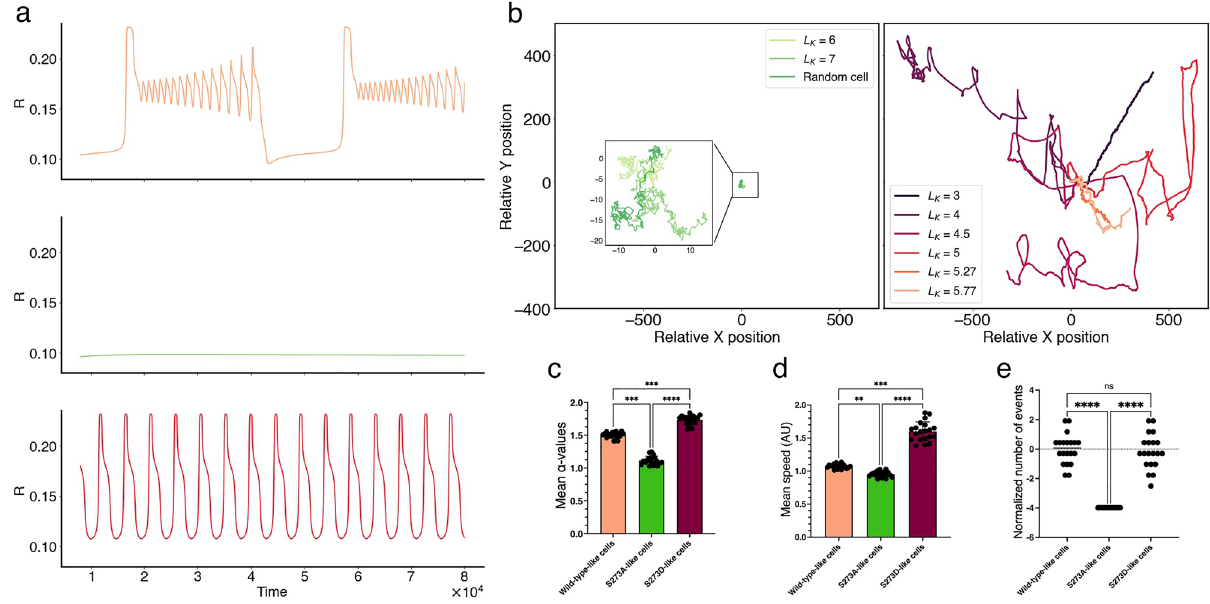
Figure 7. Role of PAK-dependent sensitivity parameter L K in defining mutant dynamics in CPM cells. ( a ) Time series simulations of active Rac in the absence of diffusion at default value of L K = 5.77 (top) showing mixed- mode oscillations (MMOs), at L K = 7 (middle) showing non-oscillatory behaviour, and at L K = 4.5 (bottom) showing relaxation oscillations (ROs). ( b ) Migration tracks of CPM cells generated by altering only L K while keeping other parameters fixed; this produced inactive (i.e., random) cells when L K > 6 (left), or actively migrating cells when L K (cid:31) 6 (right). The lower the value of L K , the further the CPM cell typically migrated. ( c ) Mean instantaneous speed, ( d ) mean α -values, and ( e ) normalized number of events evaluated over the entire simulated track from 20 cells from each of WT-like ( L K = 5.77 ), S273A-like ( L K = 7 ) and S273D-like ( L K = 4.5 ) CPM cells. Normalization of the number of events for each condition was done as in Fig. 6. The number of events in the S273A-like CPM cells did not vary because they all exhibited random inactive migration pattern; they were all zero and became negative when normalized. Error bars indicate